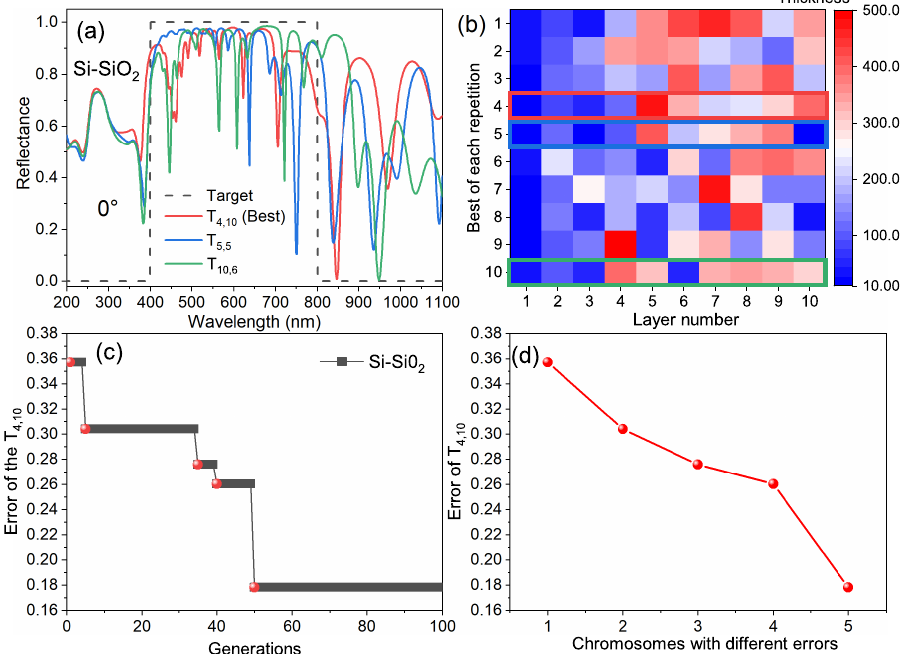
Figure 6. The optimization results for an Si-SiO 2 PC: ( a ) The black dashed lines represent the target reflectance, while the solid colored curves show the characteristic optimized spectra corresponding to the best individuals of each run for 0 ◦ of incidence; ( b ) Solution to the individual chromosome representation; ( c ) Genetic algorithm convergence process; ( d ) Chromosomal representation of the solutions with a different error. These chromosomes are the ones that present genetic variability and are the ones selected to save in the database (h5